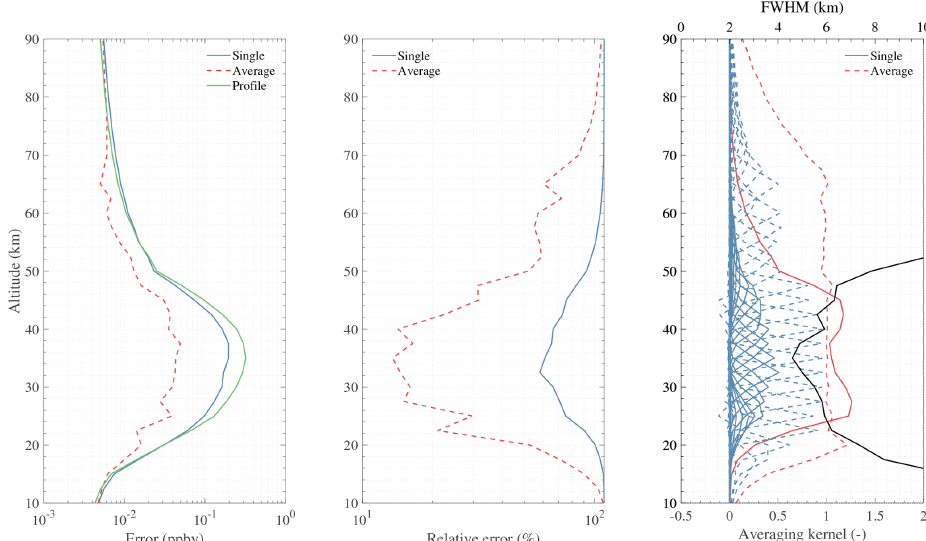
Figure 22. Simulation result of HOCl retrieval using 635.87GHz lines. “Single” and “Average” represent the retrieval error using different noise. “Profile” represents the typical profile used in the simulation. The black solid line in the last panel represents the FWHM (i.e. vertical resolution).